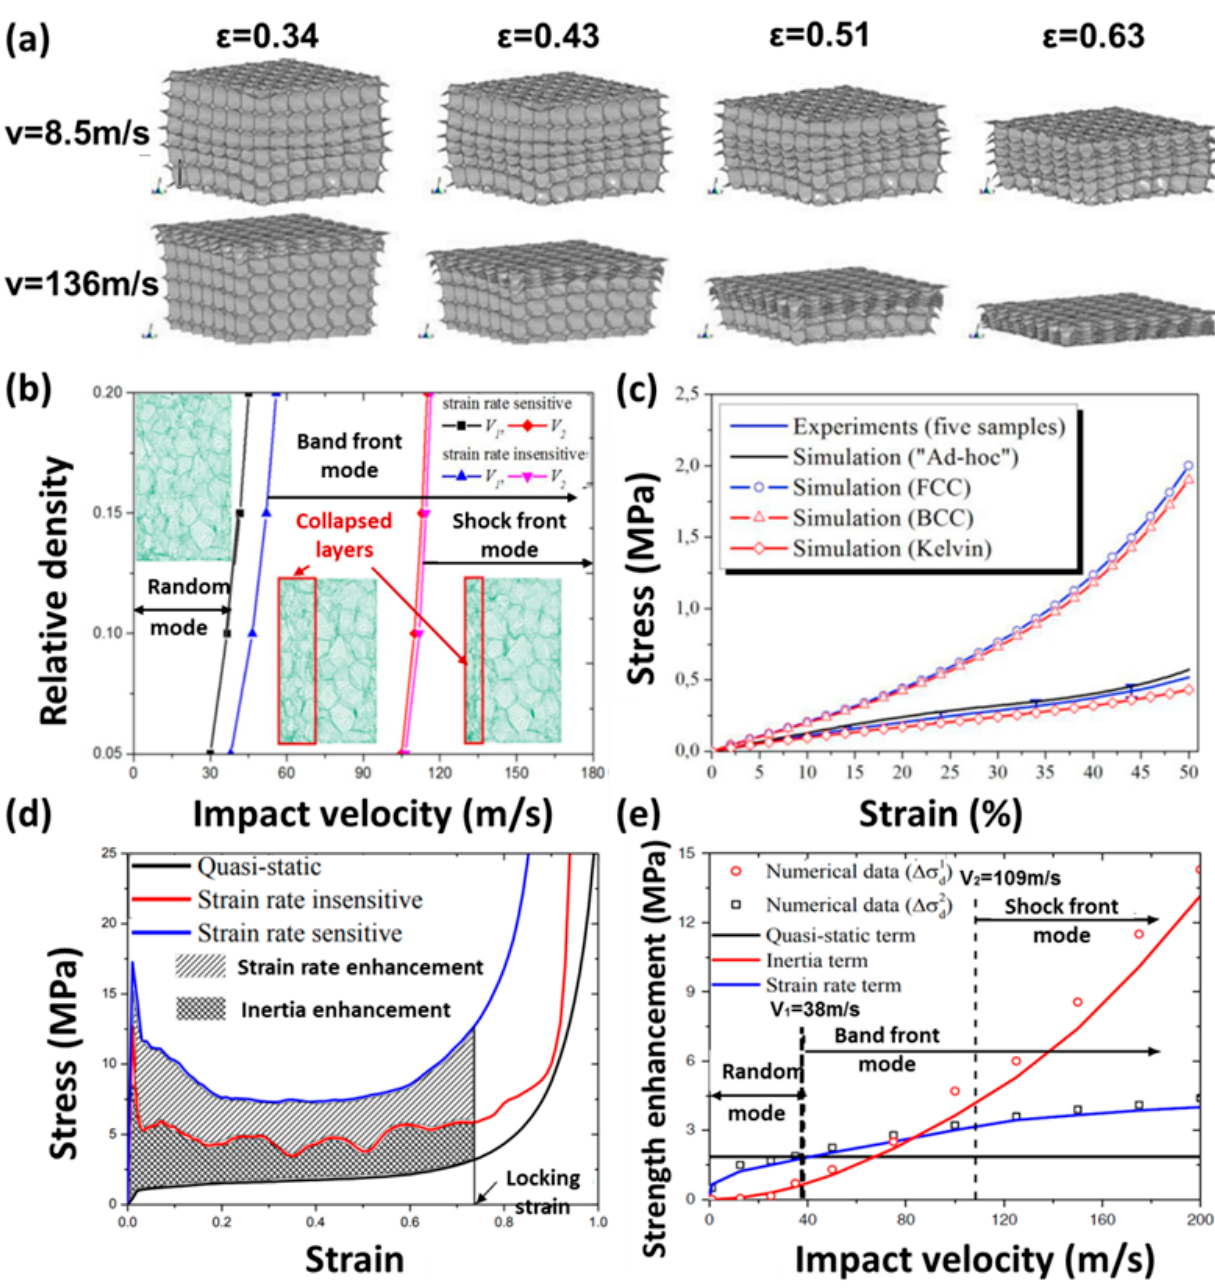
Figure 10. ( a ) Deformation process of tetradecahedron model at 8.5 m/s and 136 m/s [125], ( b ) deformation process of Voronoi model at different impact velocities [33], ( c ) stress-strain curves of Ad-hoc model, BCC model, FCC model and Kelvin model [134], ( d ) stress-strain curves of metal foam at 90 m/s [33], and ( e ) crushing strength under various impact velocities [33].